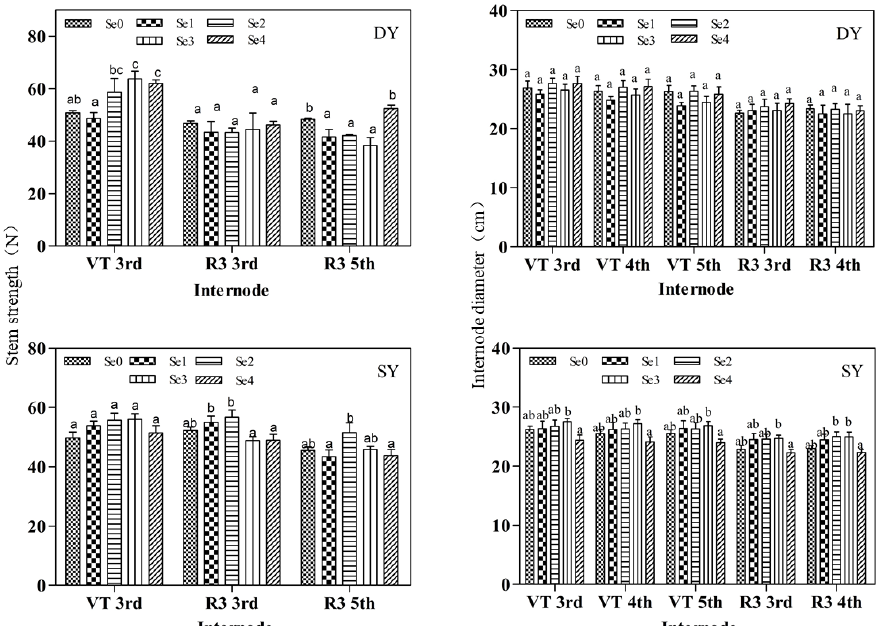
Figure 1. Effects of Se fertilizer application on stem strength and internode diameter of maize at locations DY and SY. Note: Se0, Se fertilizer application 0 g ha − 1 ; Se1, Se fertilizer application 75 g ha − 1 ; Se2, Se fertilizer application 150 g ha − 1 ; Se3, Se fertilizer application 225 g ha − 1 ; Se4, Se fertilizer application 300 g ha − 1 . Different lowercase letters in the same column indicate significant differences among different treatments ( p < 0.05).